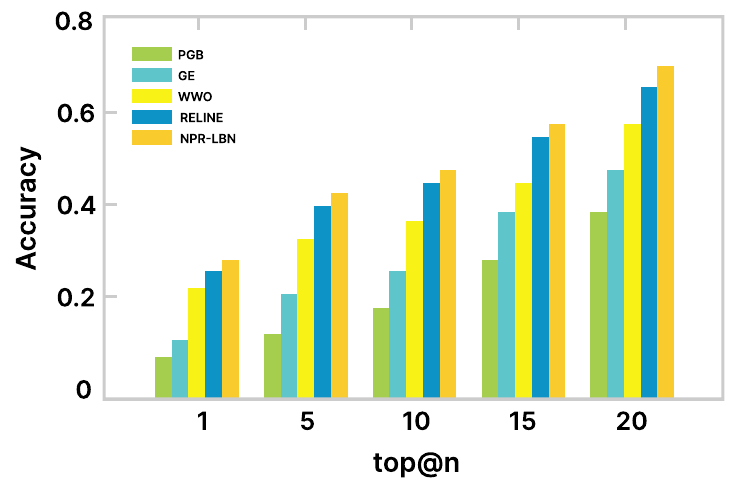
Fig. 3 Accuracy for cold-start users